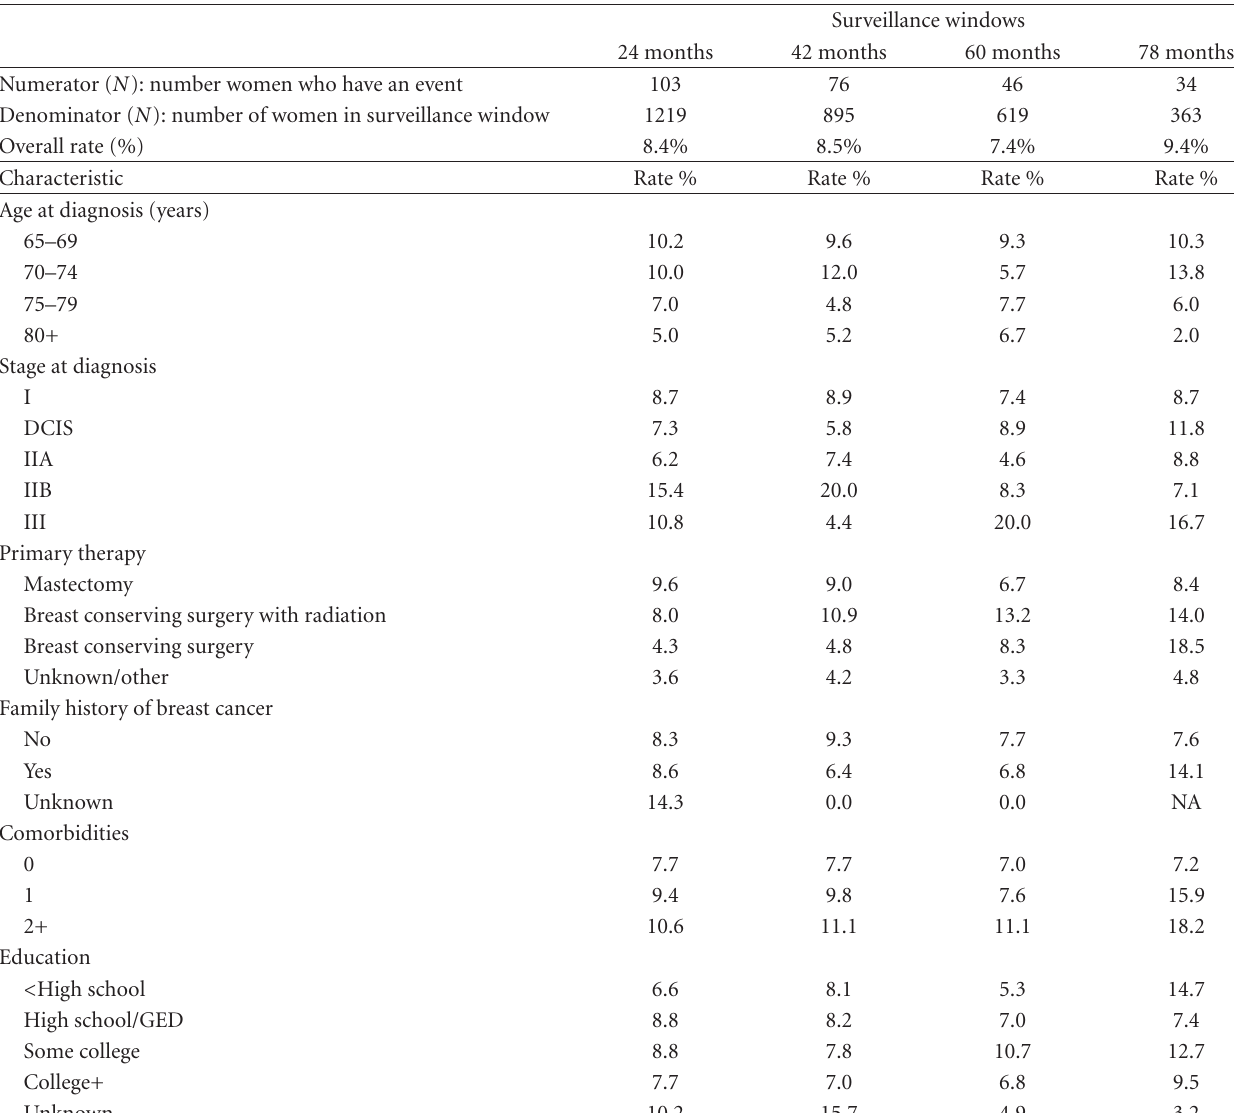
Table 4: Women’s characteristics and biopsy rates for each surveillance